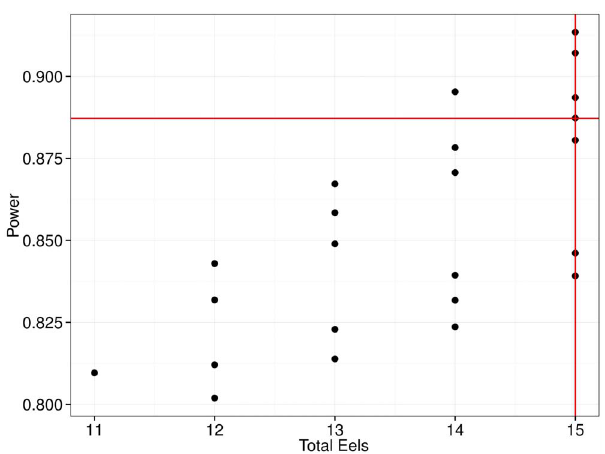
Figure 2. Unequal Cost-Efficient Designs for the European Eel Study. Red lines represent the total number of eels (15) and power (0.887) of the original longitudinal design. Four designs using fifteen eels or less are more powerful than the original